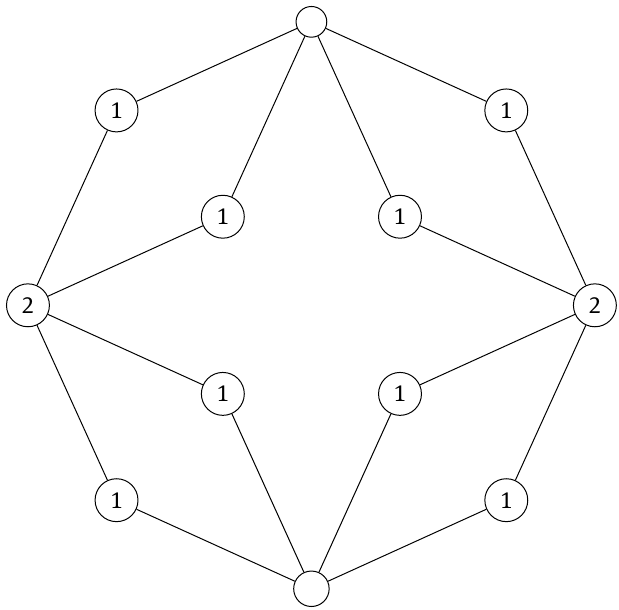
Fig. 3. Diamond D 2 in which generations of vertices are